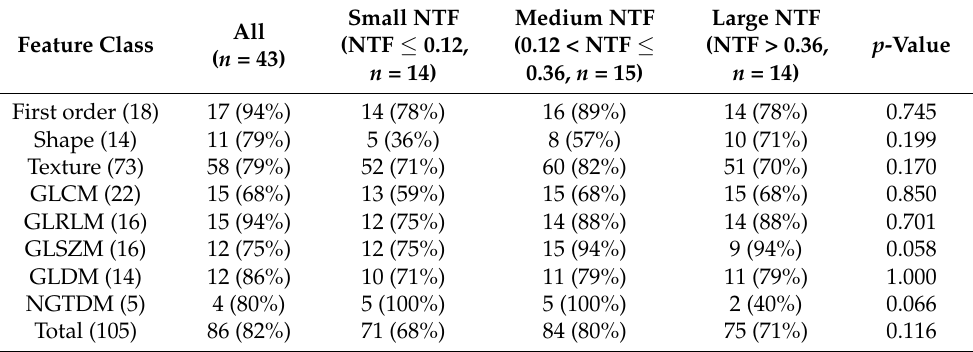
Table 3. Numbers and percentages of features affected by the delineation method (VOI vital-tumour vs. VOI gross-tumour ) per feature class for the subgroups based on NTF. Differences in the number of affected features between subgroups were assessed using the Fisher’s exact test. NTF: necrotic tumour fraction, GLCM: grey level cooccurrence matrix, GLRLM: grey level run length matrix, GLSZM: grey level size zone matrix, GLDM: grey level dependence matrix, NGTDM: neighbouring grey tone difference